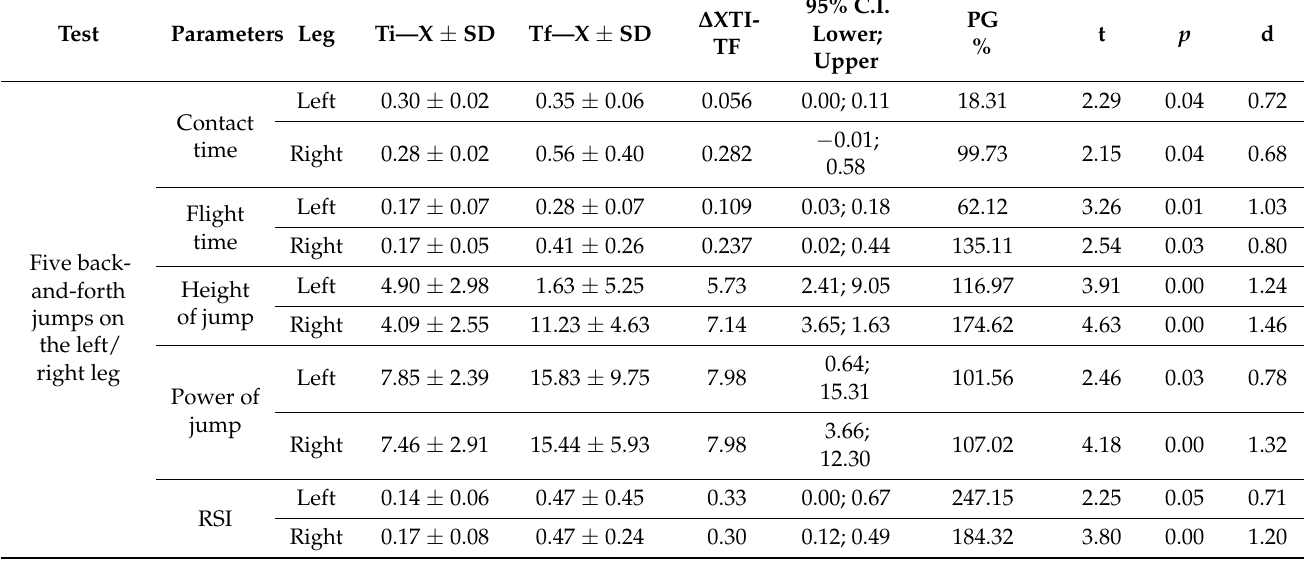
Table 2. Statistical description of the test of five back-and-forth jumps on the left/right leg.